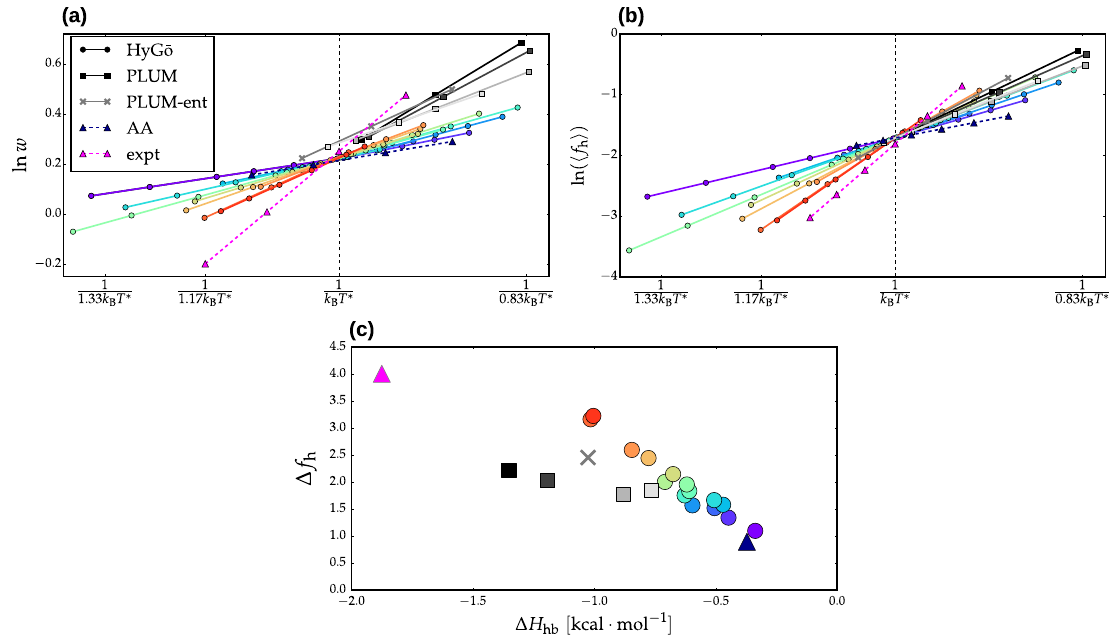
Figure 3. Temperature dependence of the Lifson-Roig helix propagation parameter, w ( a ), and the average fraction of helical segments, (cid:104) f h (cid:105) ( b ). The curves presented are a linear fit of the raw data. ( c ) The slope of ln (cid:104) f h (cid:105) ( 1/ T ) , denoted ∆ f h , versus the enthalphy of helix extension (determined as the slope of ln w ( 1/ T ) ). Data from the Hy-G¯omodels are denoted with circle markers and are colored according to their relative cooperativity (as determined by ∆ f h ). The results from the PLUM models are colored in gray-scale according to ∆ H hb . The energetic reparametrizations of PLUM are indicated with square markers, while the PLUM-ent model is indicated with X markers. The experimental and all-atom results taken from Best and Hummer [31] are denoted with triangle magenta and dark blue markers, respectively. Note that the models are aligned by shifting the temperature such that all models achieve (cid:104) f h (cid:105) expt at T ∗